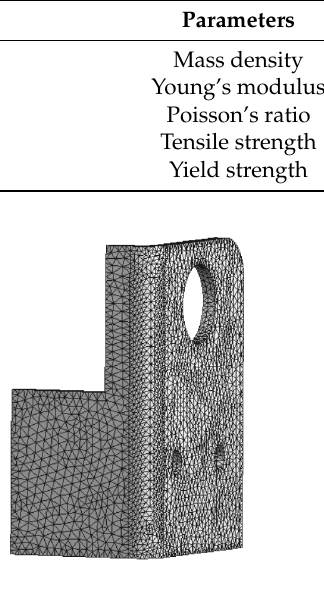
Figure 3. The effect of model meshing.